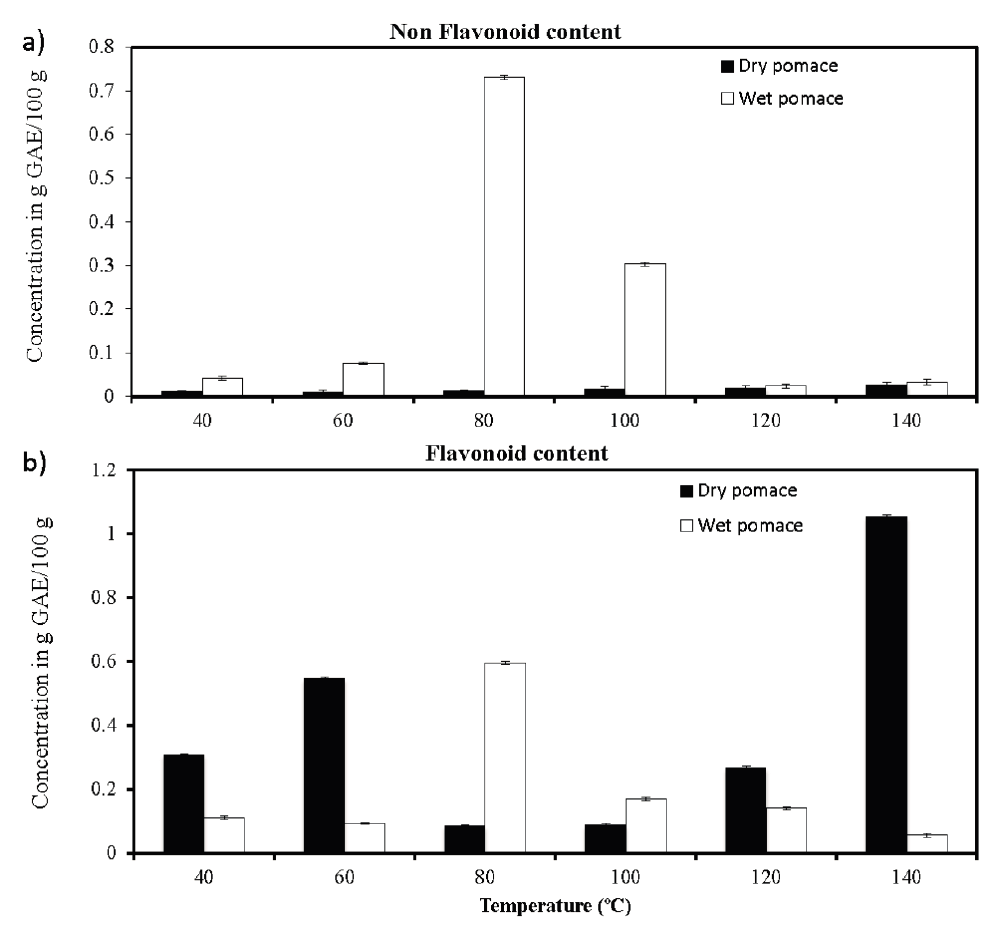
Figure 6. Histograms representing the quantification of non-flavonoids ( a ) and flavonoids ( b ) molecules extracted from dry and wet grape pomace at 40, 60, 80, 100, 120 and 140 °C as obtained by HPLC-UV